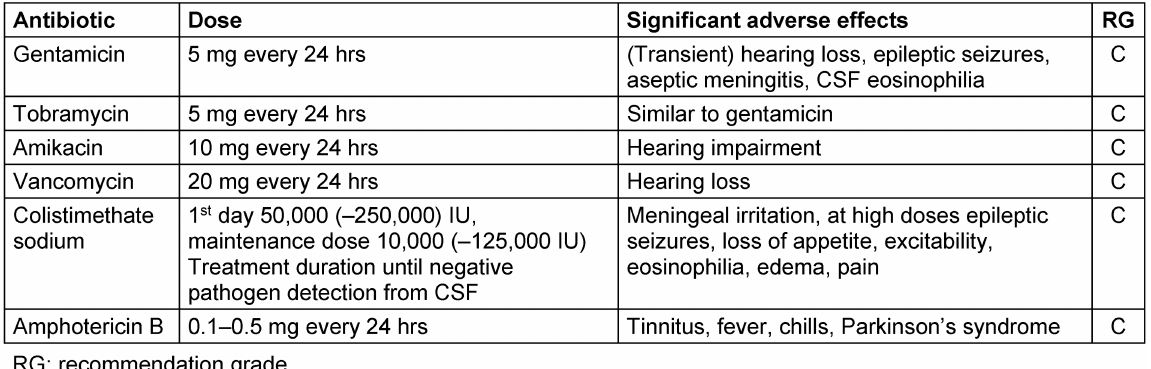
Table 3: Intraventricular antibiotic treatment (usually simultaneous systemic treatment is